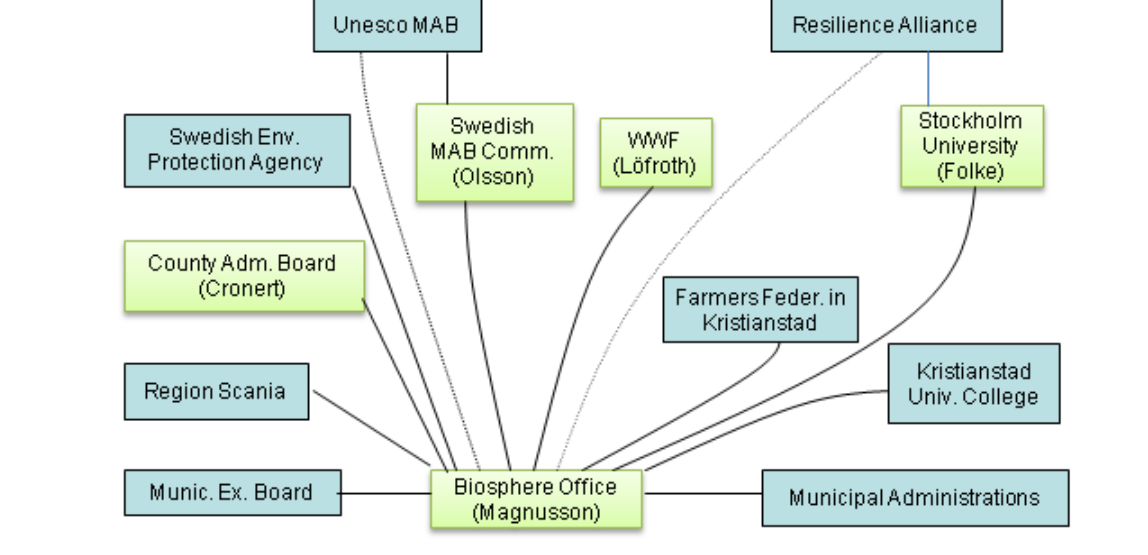
Fig. 1 . The governance network of KVBR. There are links between several of the other nodes as well, but all nodes except Unesco MAB and the Resilience Alliance became involved in the governance network after initial contacts by Magnusson at the BO. The nodes are agencies/organizations, except in five cases (noted by names) in which the nodes could be described as individuals who created their own mandates within their respective